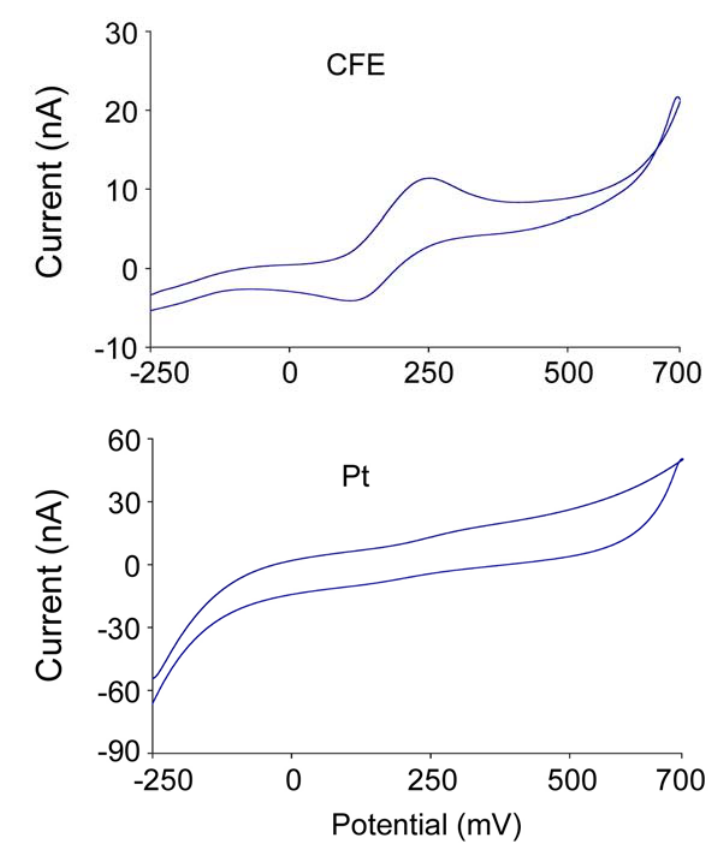
Figure 3. Cyclic voltammogram recorded for carbon fiber and Pt electrodes vs. Ag/Ag/Cl in 1 mg/mL osmium redox polymer solution at 100 mV/s displayed on two current density scales. The scan for the CFE was in a smaller magnitude and showed the oxidation/reduction peaks; while for the Pt electrode, there were no detectable oxidation/reduction